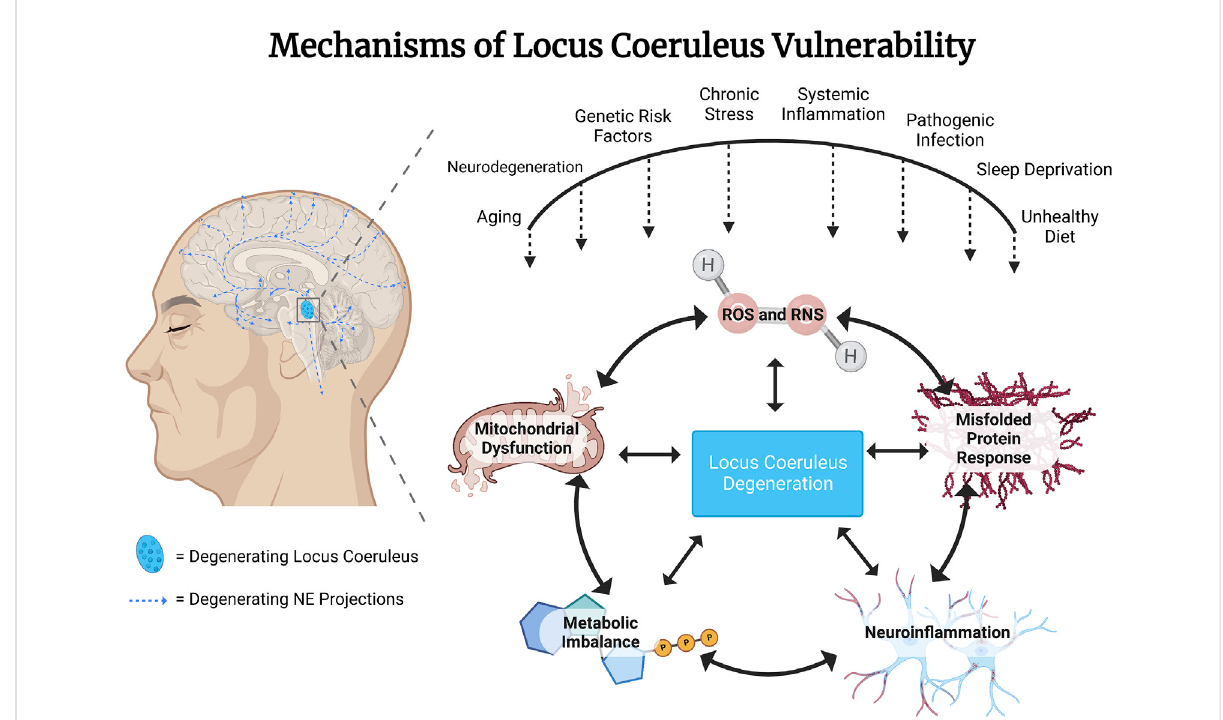
FIGURE 1 Genetic and environmental risk factors converge to confer vulnerability to locus coeruleus (LC) noradrenergic (NE) neurons. Proximate mechanisms of vulnerability that have been suggested to contribute to LC NE degeneration include actions of reactive oxygen and nitrogen species (ROS/RNS), response to misfolded proteins, neuroin fl ammatory mechanisms, metabolic imbalance and mitochondrial dysfunction due to high baseline rates of neuronal